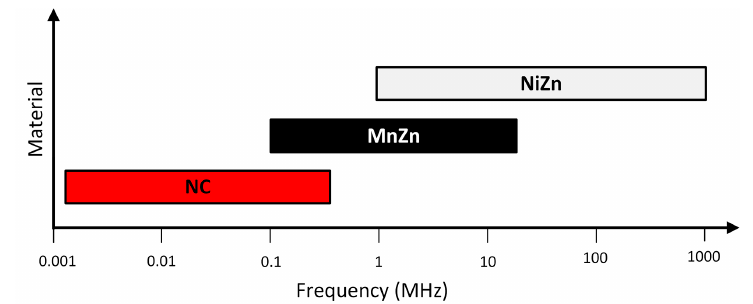
Figure 6. Material composition versus frequency range covered.